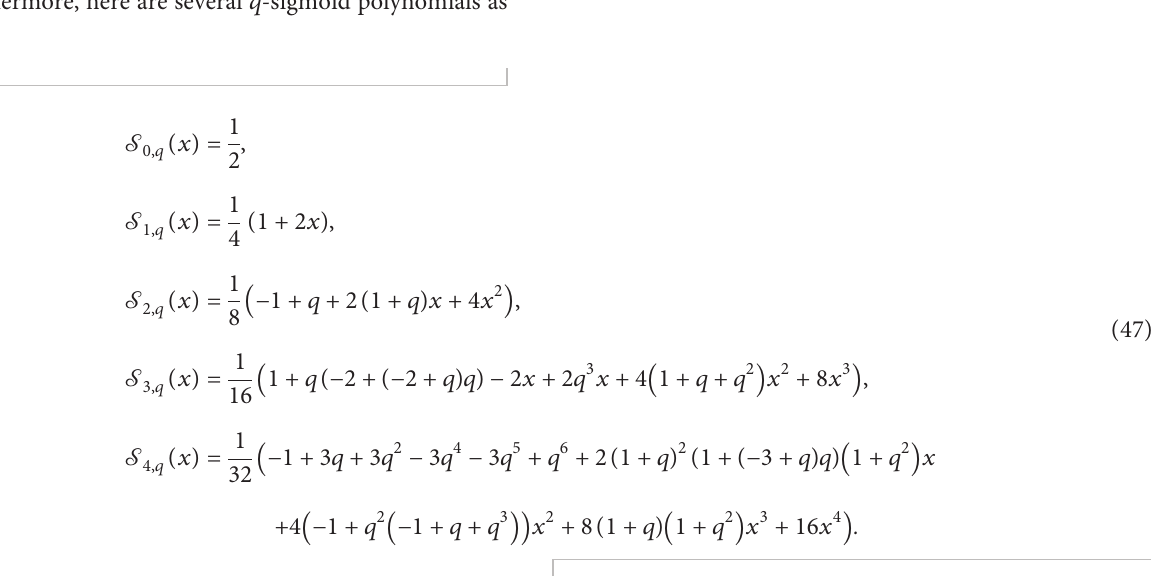
( x ) for n � 10 , 30 , n, 0 . 1